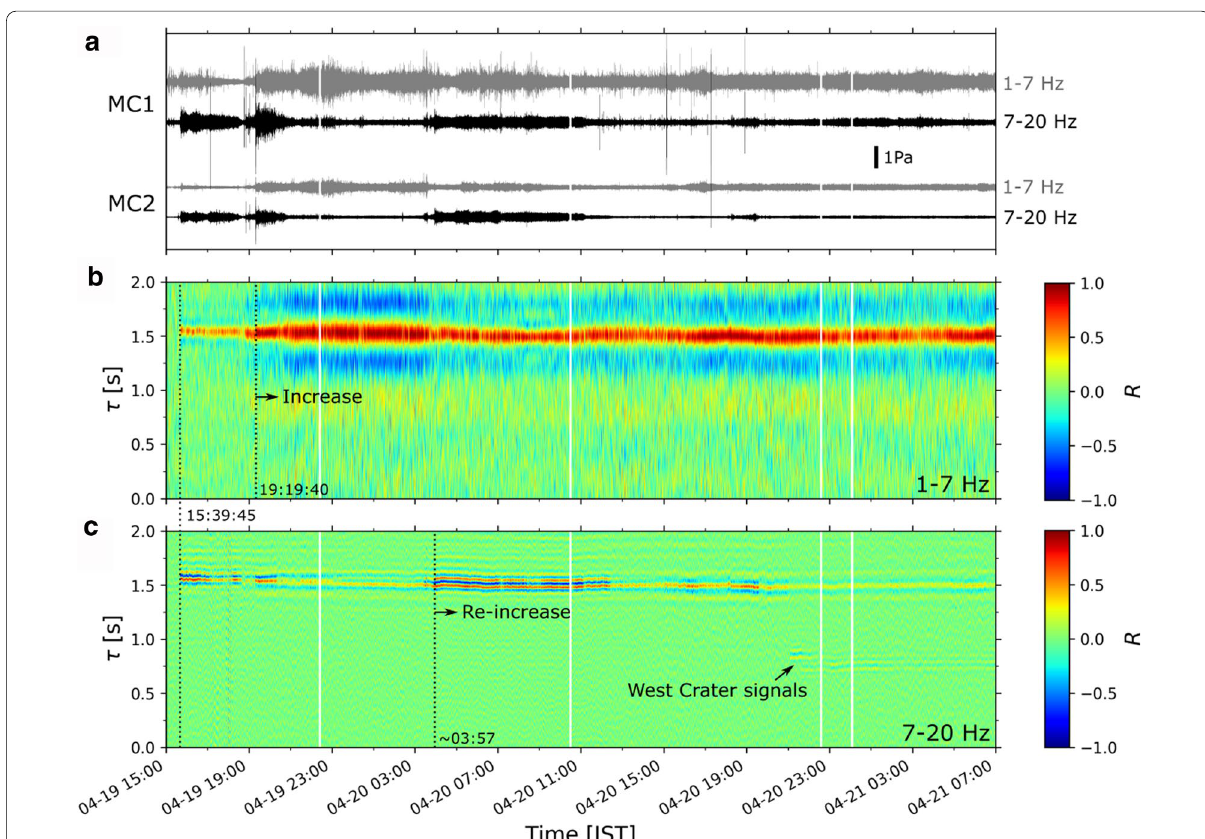
Fig. 3 Cross-correlation analysis between MC1 and MC2. The vertical white lines represent periods with missing data. a Waveforms filtered 1–7 Hz (gray lines) and 7–20 Hz (black lines) recorded by MC1 and MC2. b The t − τ plot of the cross-correlation coefficient in the frequency range of 1–7 Hz. The signal starts with the eruption onset at 15:39:45 on April 19, and the correlation values increase from 19:19:40 on April 19 (black dotted line). c The cross-correlation coefficient in the frequency range of 7–20 Hz. The correlation peaks appear with the eruption onset and re-intensify after around 3:57 on April 20 (black dotted